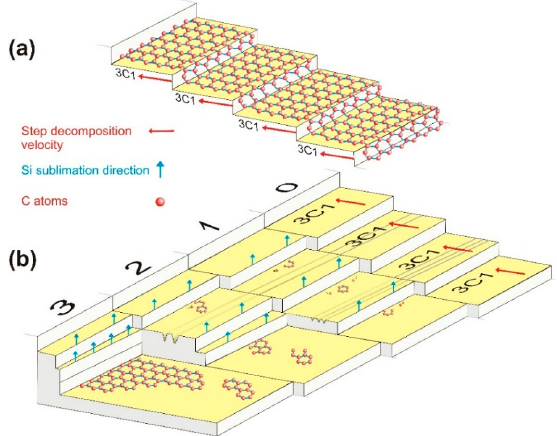
Figure 40. Graphene growth evolution (buffer layer formation not shown): ( a ) on a defect-free 3C-SiC substrate; ( b ) on a 3C-SiC with defects (lines indicate stacking faults) [22].